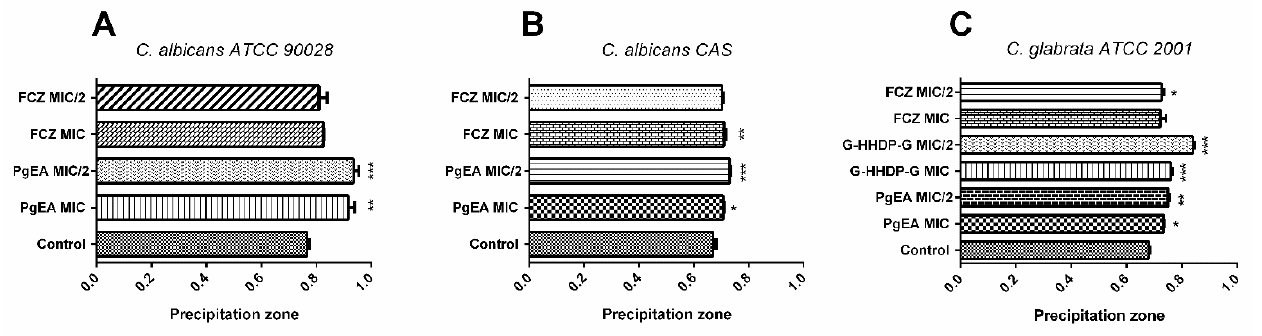
Figure 5. Evaluation of the degree of interference mediated by effect ethyl acetate fraction of P. granatum (PgEA), Galloyl-Hexahydroxidifenoil-Glucose (G-HHDP-G), and Fluconazole (FCZ) on Candida spp. phospholipase production. ( A ) C. albicans ATCC 90028, ( B ) C. albicans CAS, and ( C ) C. glabrata ATCC 2001. * p < 0.05, ** p < 0.01, and *** p < 0.0001. Table 6. Candida spp. extracellular phospholipase activity when treated with PgEA, G-HHDP-G, and FCZ, as evaluated in egg yolk medium in terms of the precipitation zone.